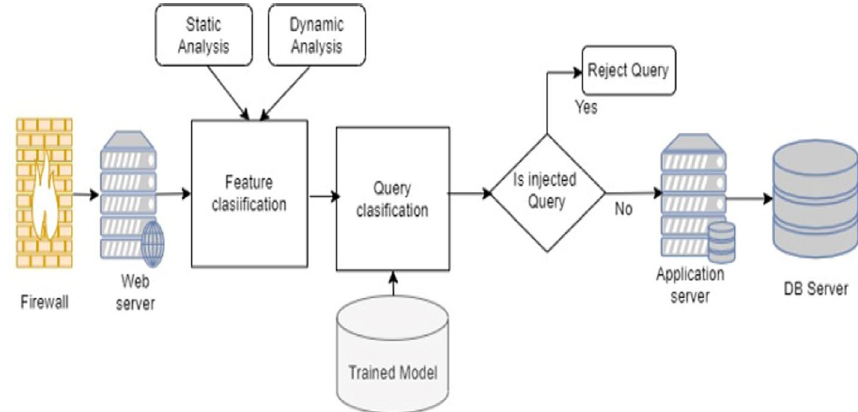
Fig. 3 Proposed framework for SQLI attack detection and prevention